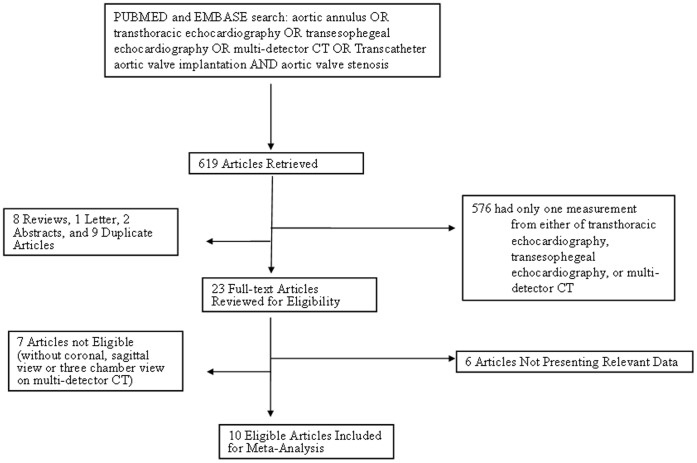
Flowchart of study selection.